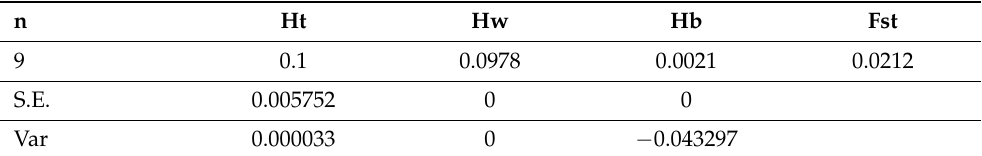
Table 6. Population genetic structure of 9 populations of G. kola